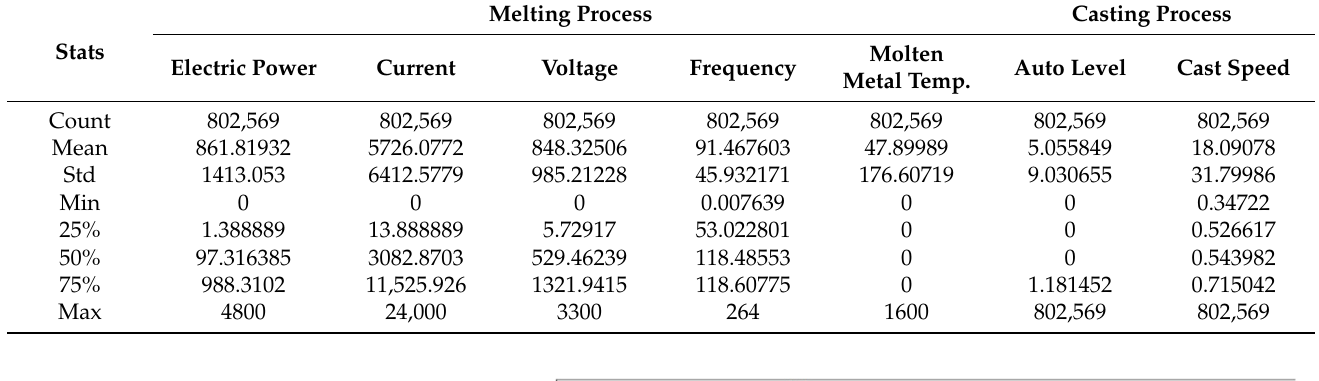
Table 4. Statistical summary of data from melting and casting processes.